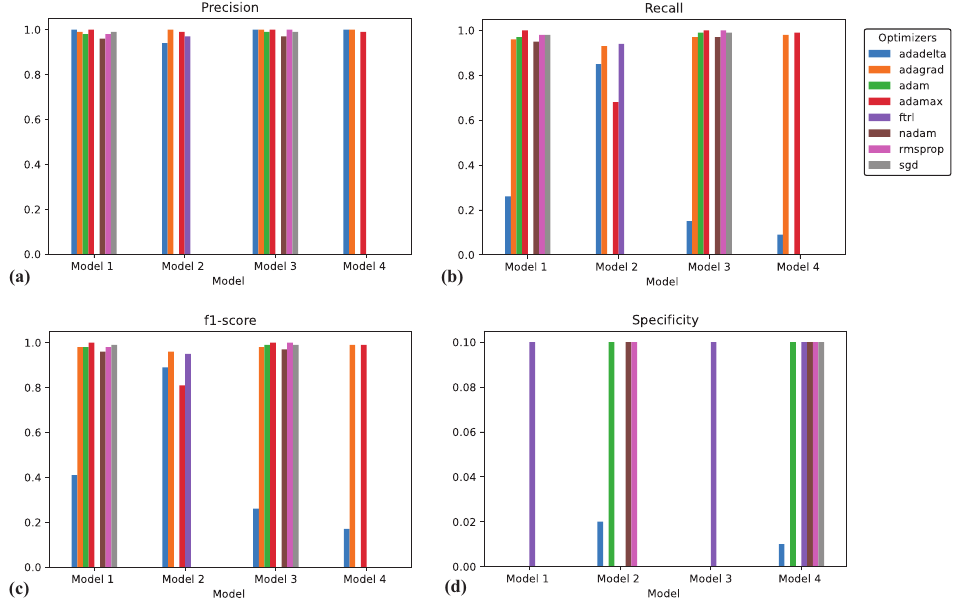
Figure 8. ( a ) Precision, ( b ) recall (sensitivity), ( c ) f1-score (accuracy), and ( d ) specificity for Case II, δ frequency, all EEG channels.